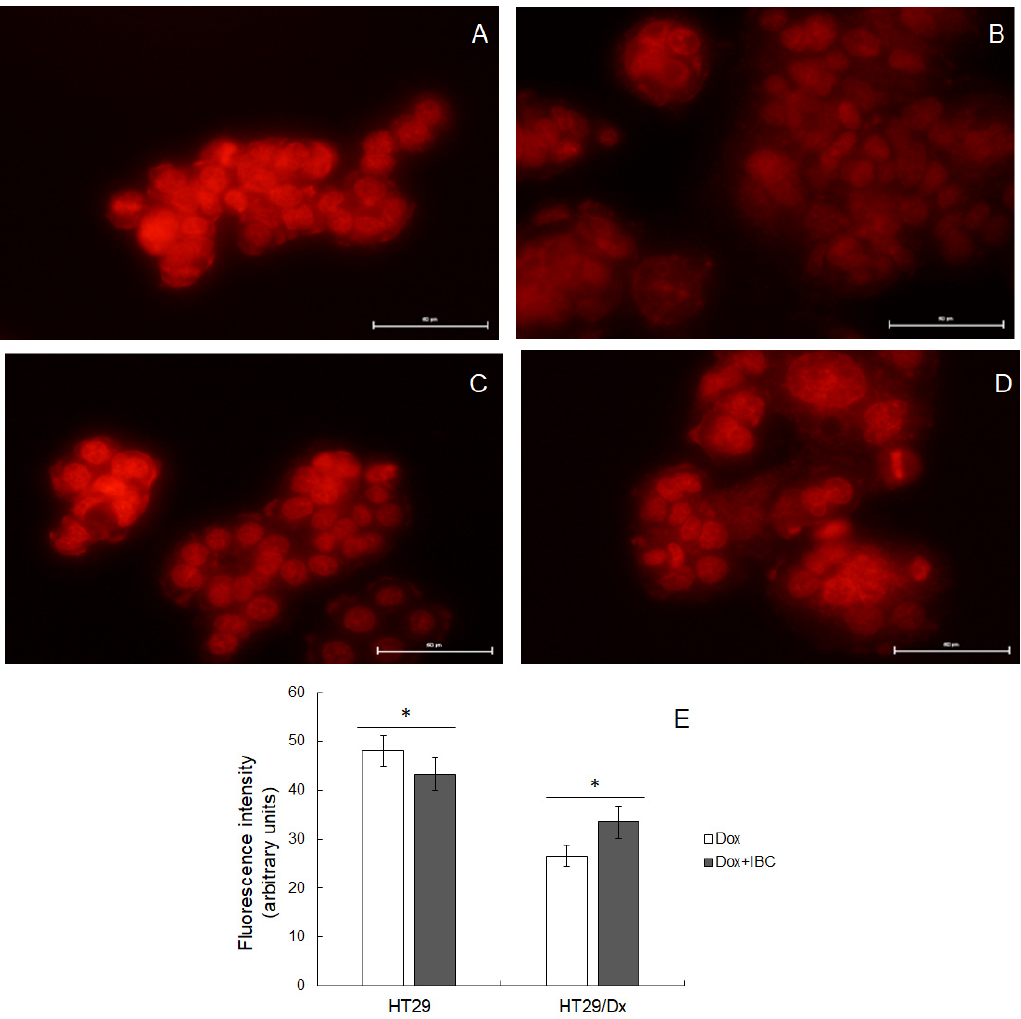
Figure 2. Microscopic images of Dox fluorescence observed in HT29 ( A ) and HT29/Dx cells ( B ) in the presence of IBC (at 15 μ M) ( C , D ) for HT29 and HT29/Dx cells, respectively). Scale bar is 50 μ m. Illumination conditions were the same for all images. Intensity of intracellular fluorescence as measured by ImageJ software ( E ) is presented as the mean fluorescence values ± SD measured in 20 representative cells. The statistically significant differences between IBC-treated and untreated cells were determined using Student’s t -test (* p < 0.05).